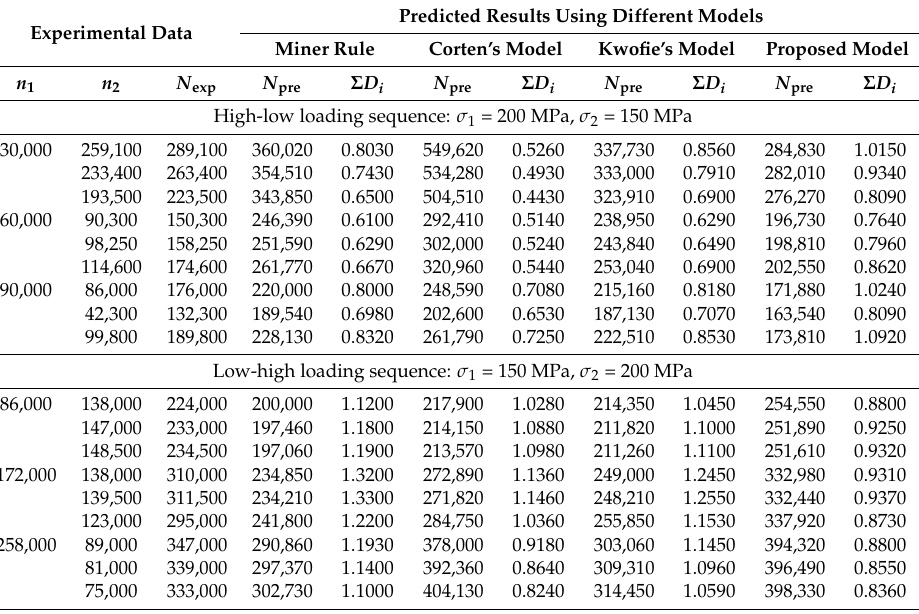
Table 3. Experimental data and models predictions for Al-2024-T42 aluminum alloy.